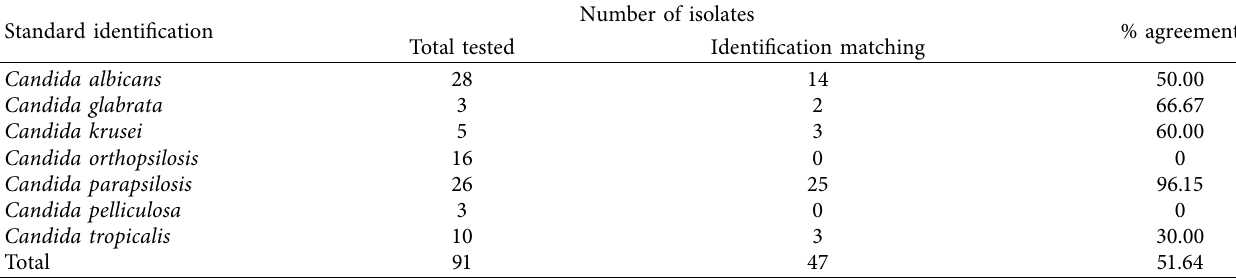
Table 1: Candida species identified directly from 91 blood culture samples from 46 patients.